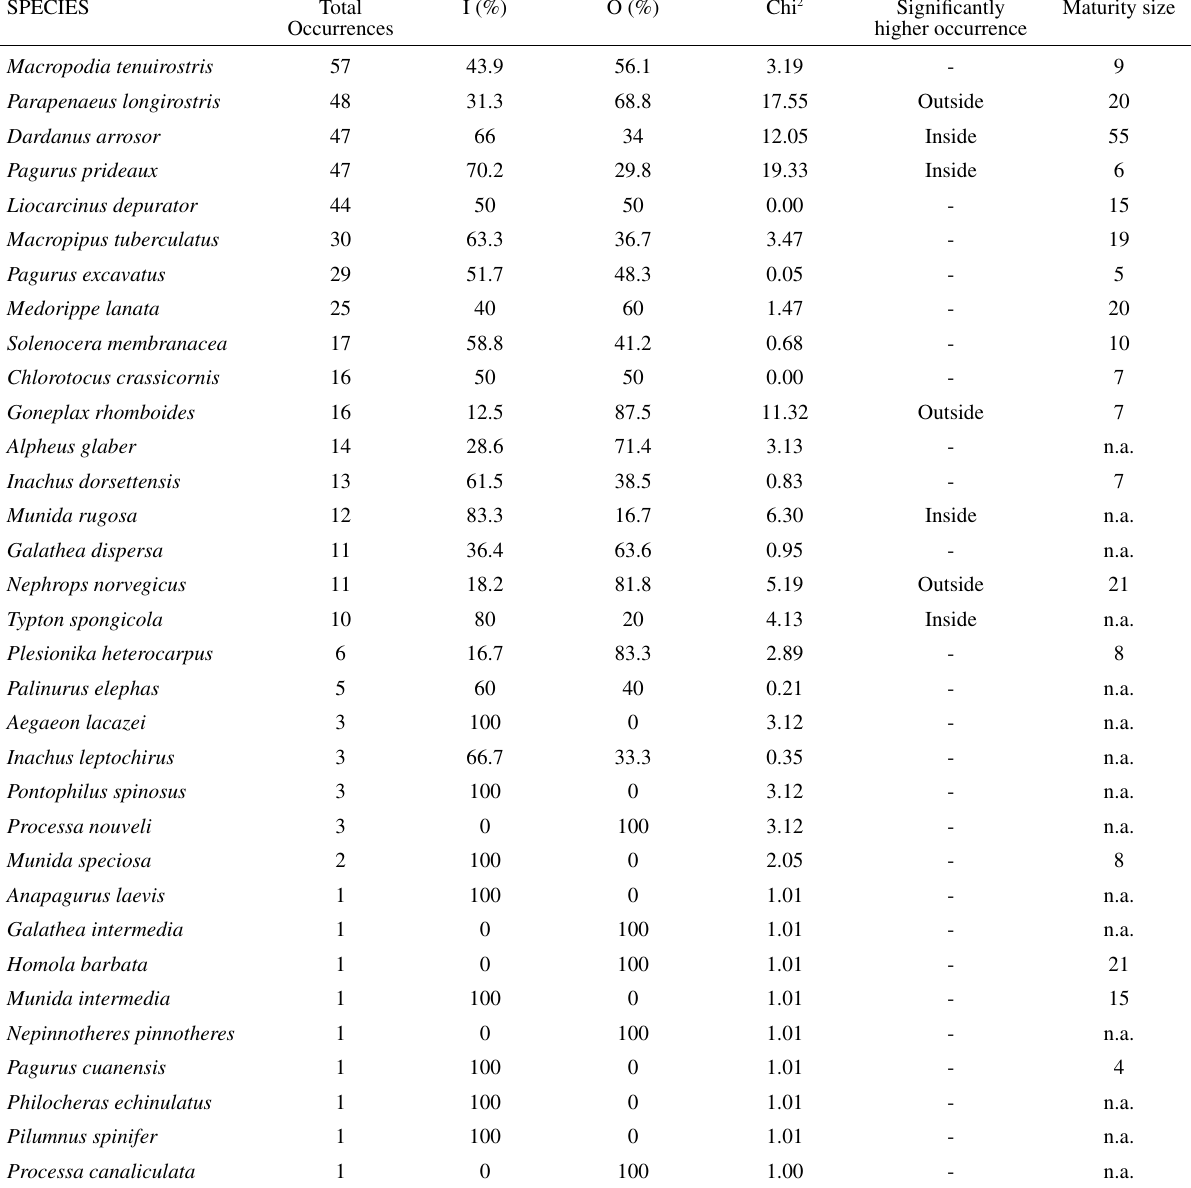
Table 2. – Total number of occurrences for each species, percentage occurrence of the species Inside and outside the no-take area, chi-squared value (p=0.05) obtained in the comparisons to test for a significantly higher occurrence in each area. SPECIES Total